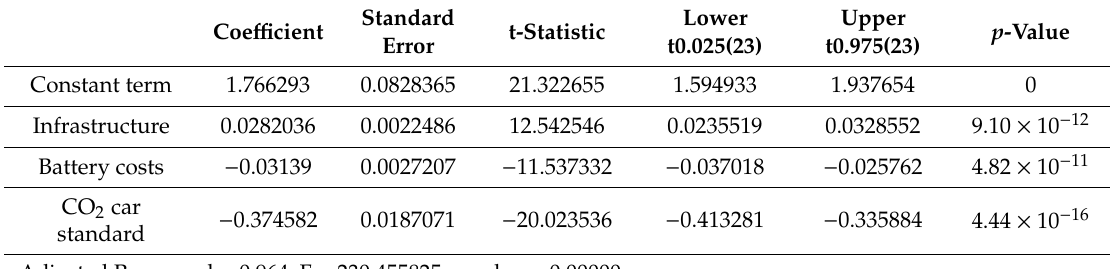
Table 4. The results of multiple regression for the EV market shares in